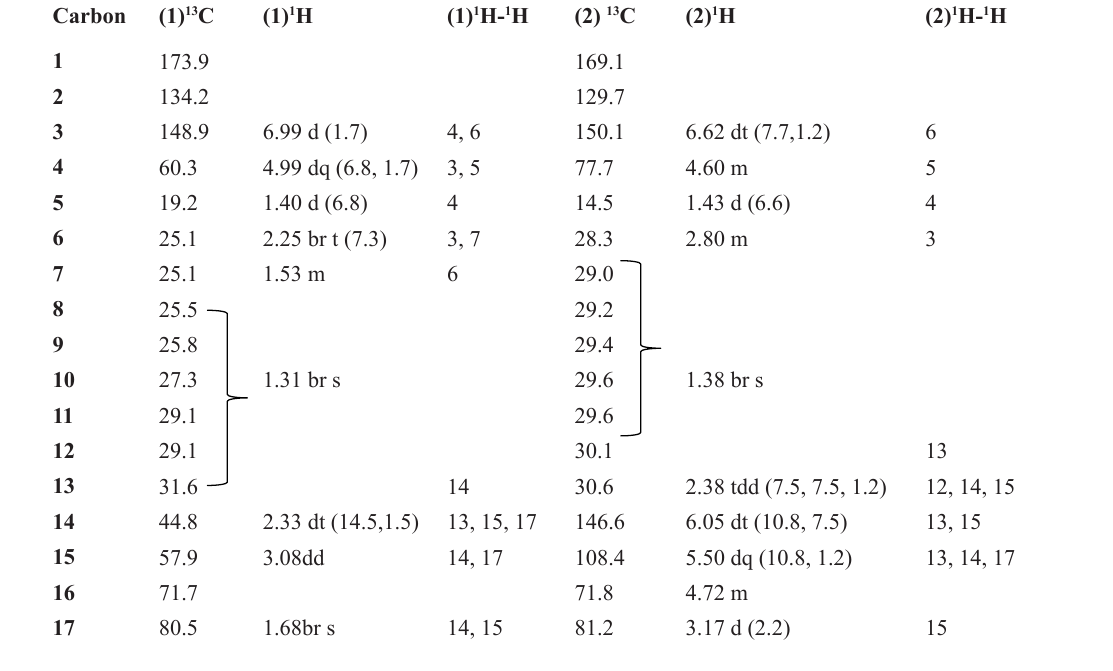
Table 1: NMR spectroscopic data of epoxy butenolides1 and 2.